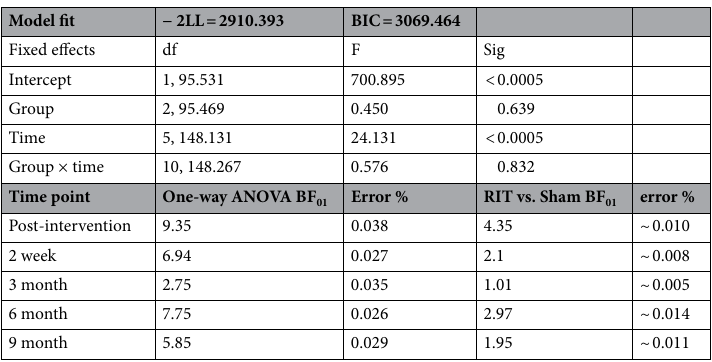
Table 3. Linear mixed model parameters for Binge Eating Scale scores and Bayesian ANOVA and Welch’s t-tests for group differences and the contrast RIT > sham at all post-intervention time points. BIC Bayesian Information Criterion, − 2LL = − 2 log